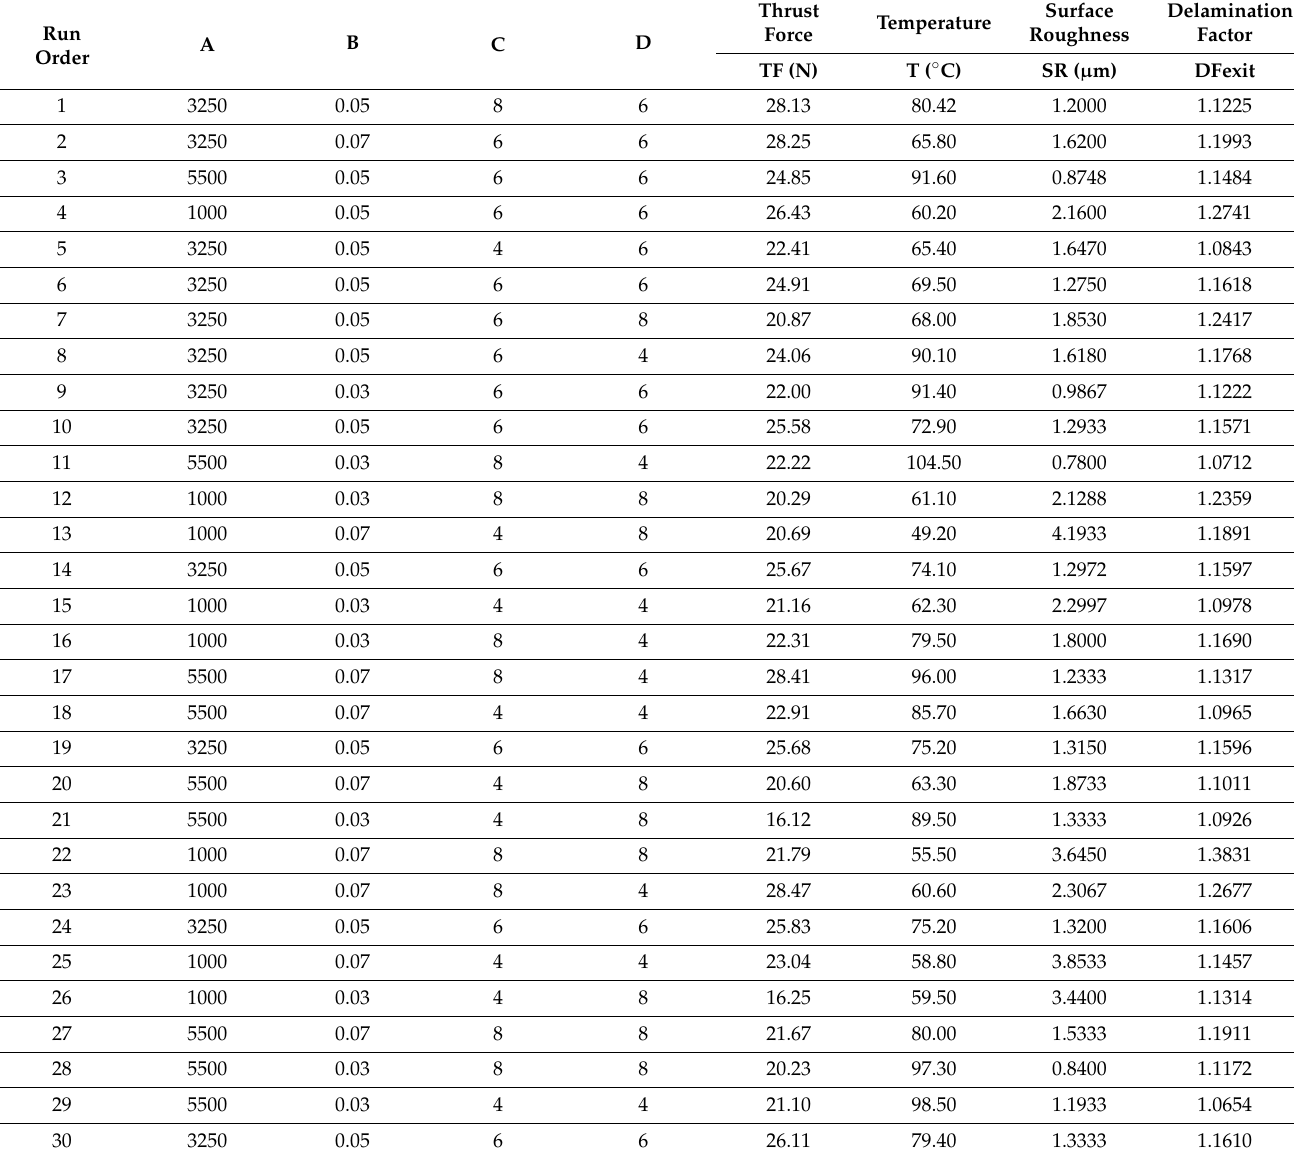
Table 4. Drilling experiment design matrix and responses of MoS 2 -reinforced